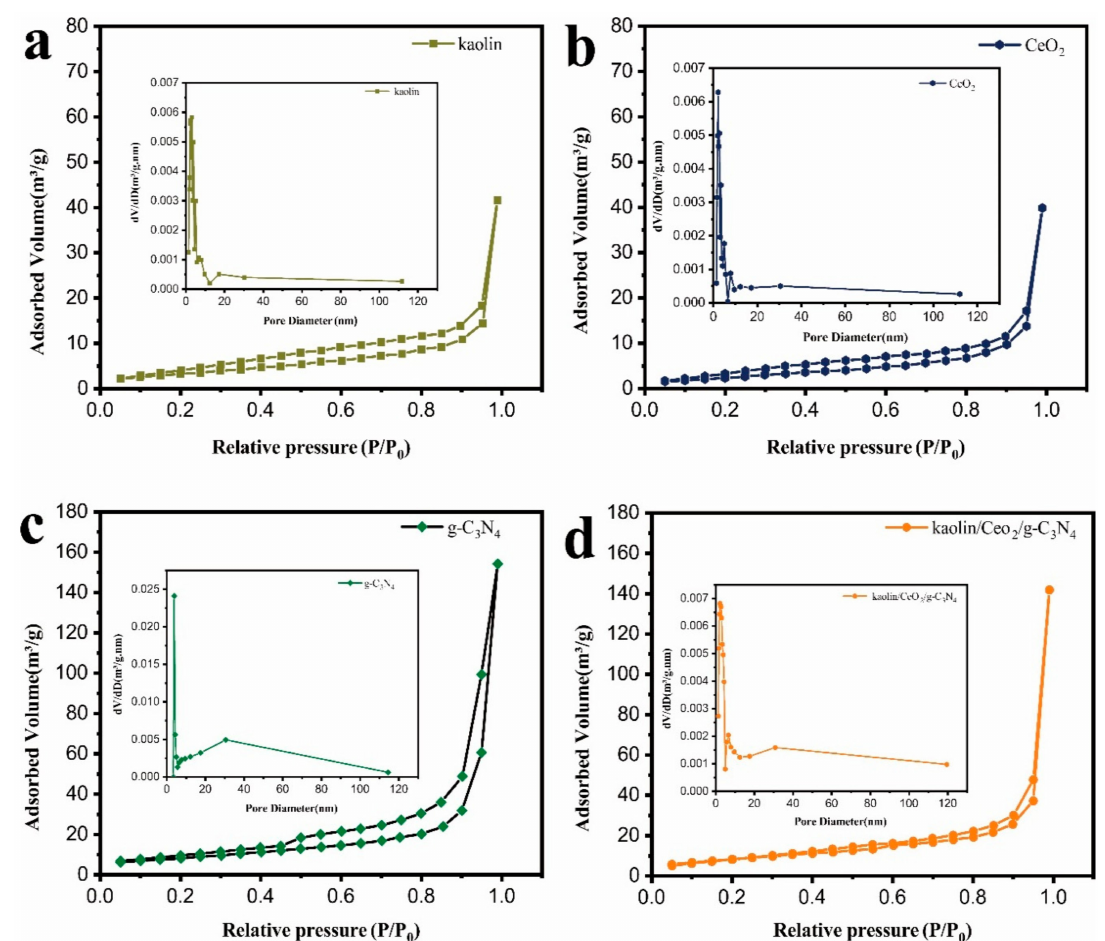
Figure 5. N 2 adsorption desorption isotherms of ( a ) kaolin, ( b ) CeO 2 , ( c ) g-C 3 N 4 and ( d ) the kaolin / CeO 2 / g-C 3 N 4